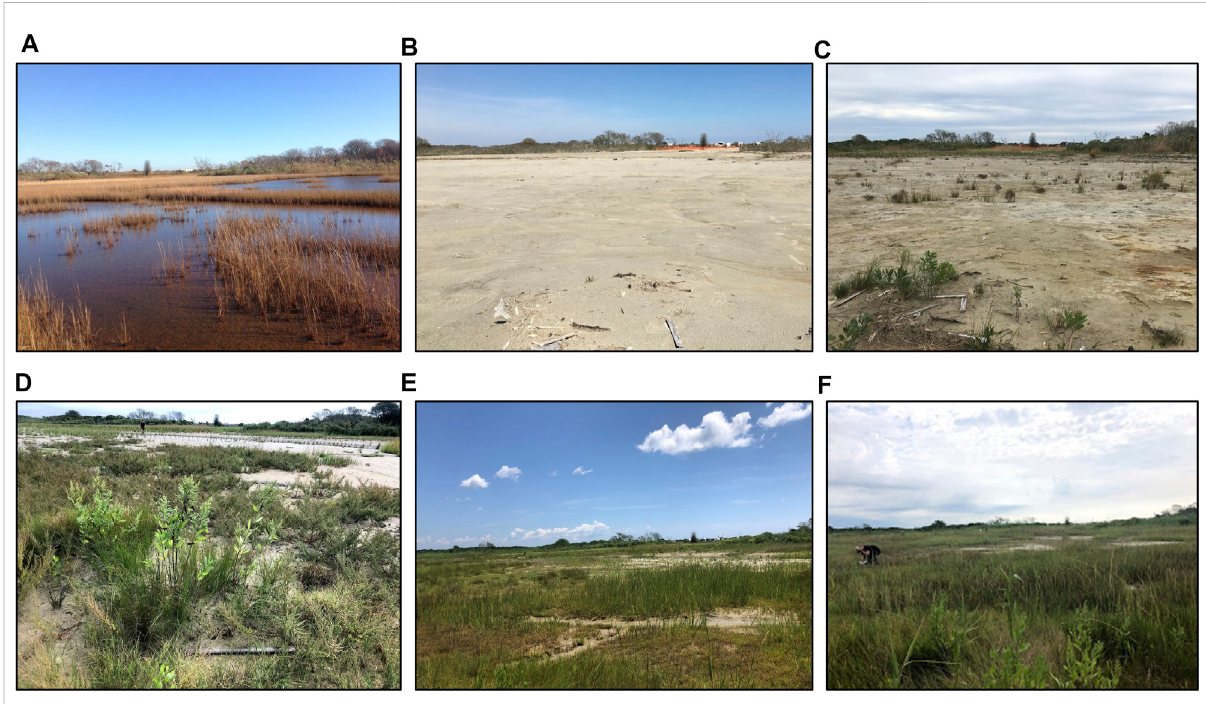
FIGURE 2 Time series photographs of the Ninigret sediment placement marsh. Initial conditions (A) , immediately after sediment placement (B) , fi rst growing season after sediment placement (C) , and second (D) , third (E) and fourth (F) growing seasons (2018 –